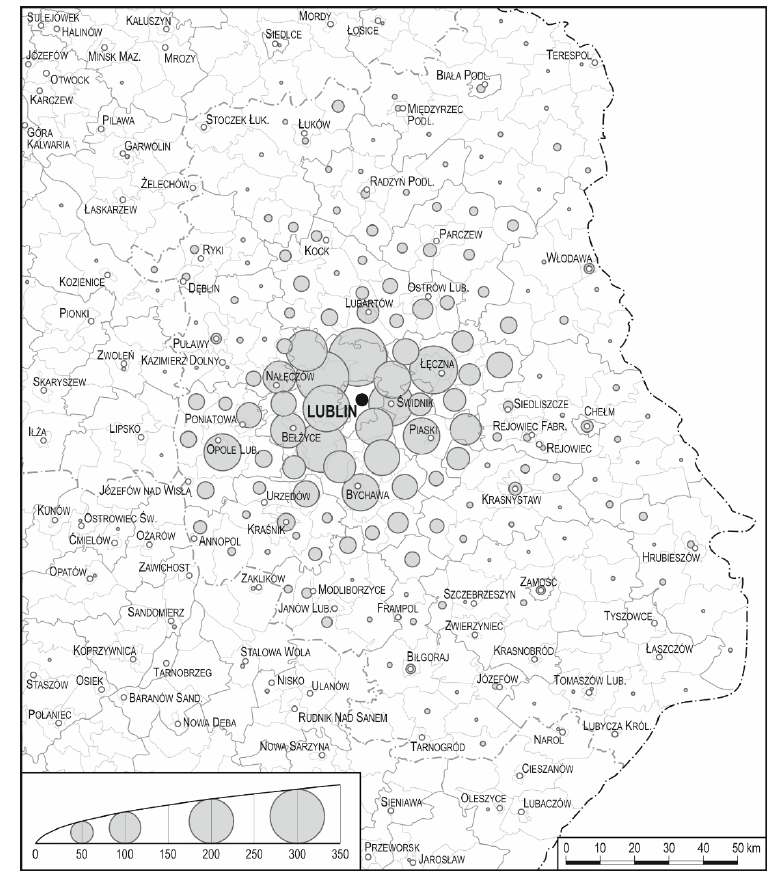
Figure 2: Spatial distribution of graduates residing outside Lublin before secondary school